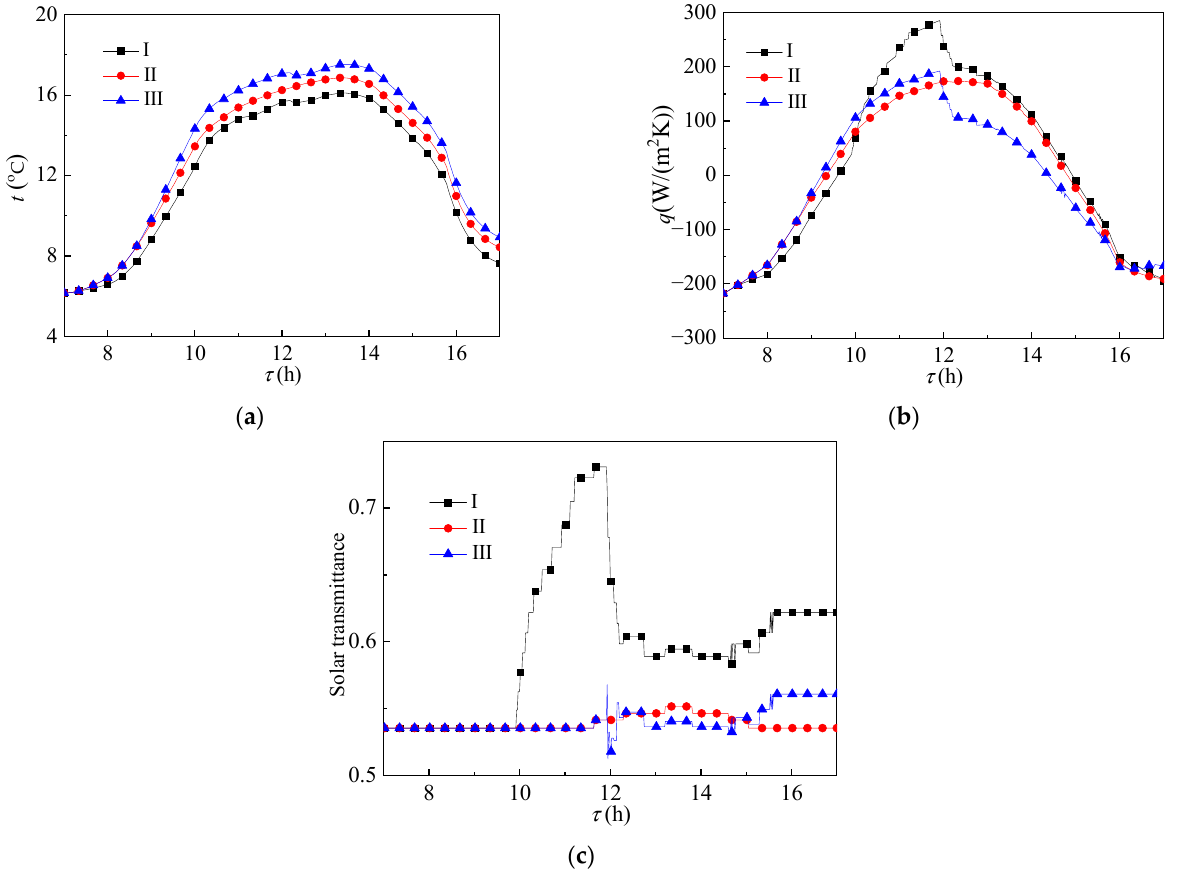
Figure 4. Change of ( a ) temperature, ( b ) heat flux, and ( c ) solar transmittance of the glass envelope over time.